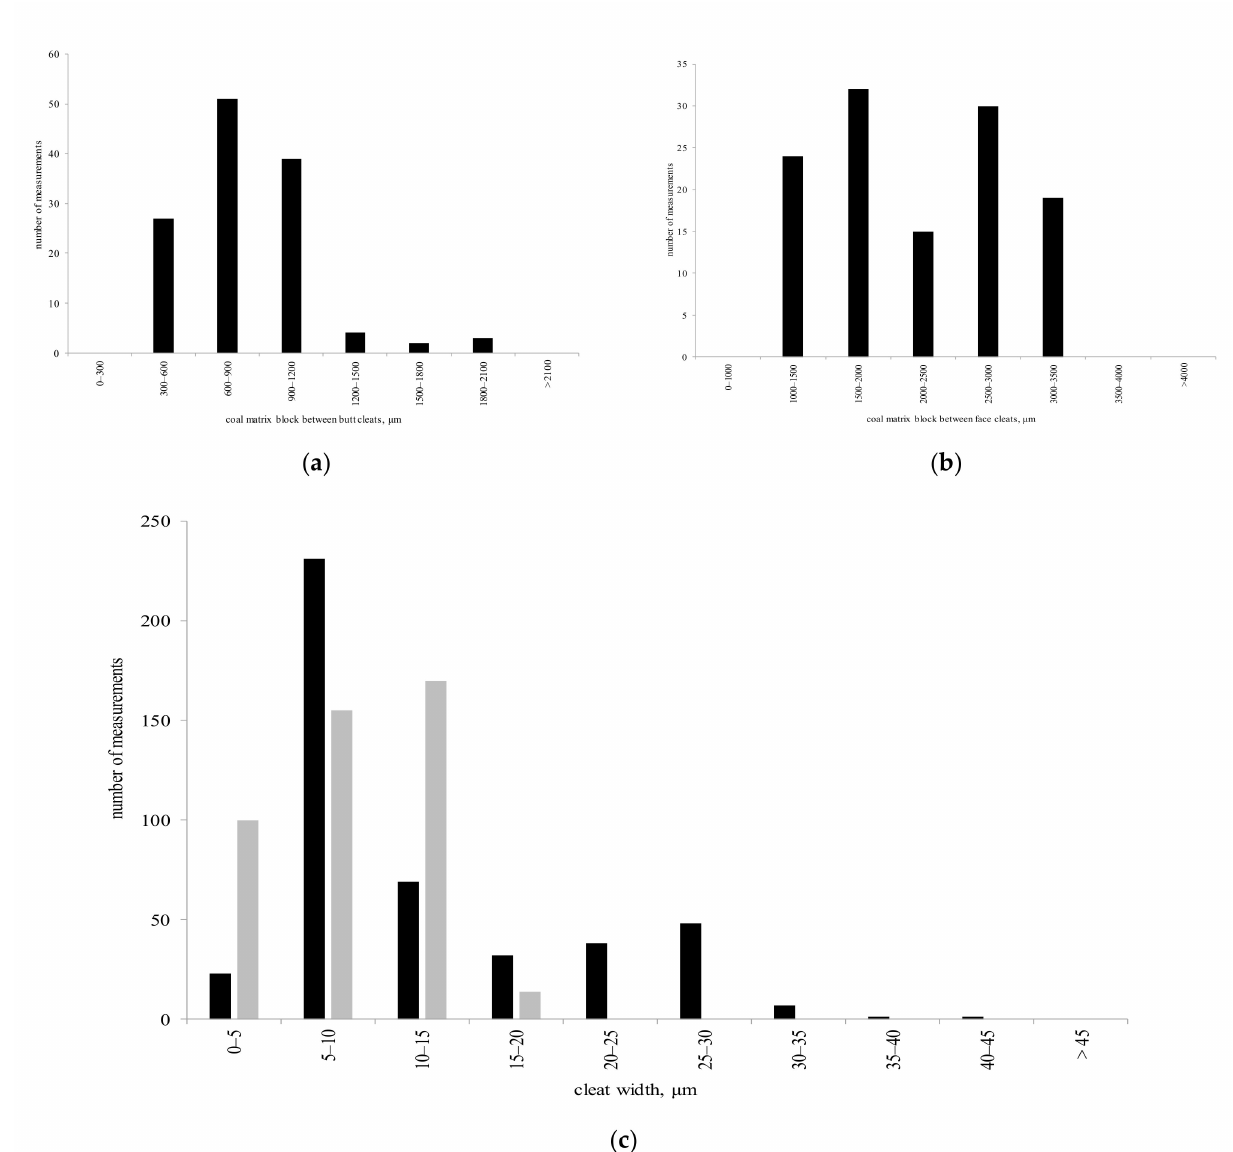
Figure 8. Distribution histograms of the measured coal cleat parameters, S.D. Tihov mine, Leninsky area, Kuzbass: coal matrix block size between butt cleats, A b ( a ); coal matrix block size between face cleats, A f ( b ); width of the face (a f , black color) and butt (a b , gray color) cleats ( c